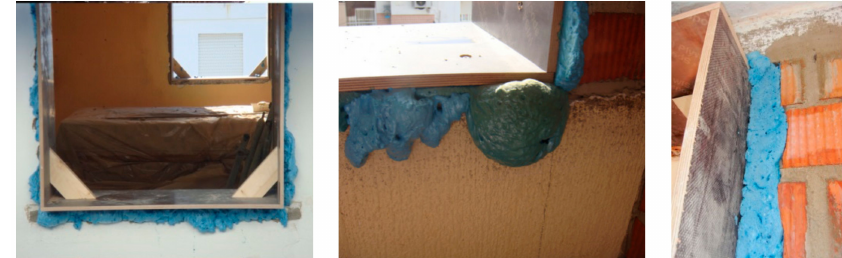
Figure 14. Special joints and high-durability flexible self-expanding polyurethane foam used.